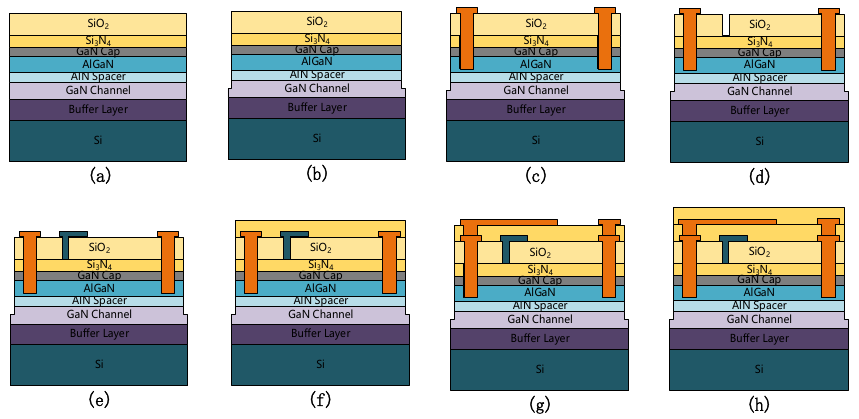
Figure 7. Fabrication flow chart of AlGaN/GaN HEMT device. ( a ), passivation: SiO 2 dep; ( b ) mesa etch; ( c ) ohmic contact; ( d ) gate trench etching; ( e ) gate metal dep; ( f ) passivation: Si 3 N 4 dep; ( g ) ohmic metal dep; ( h ) surface passivation: Si 3 N 4 dep